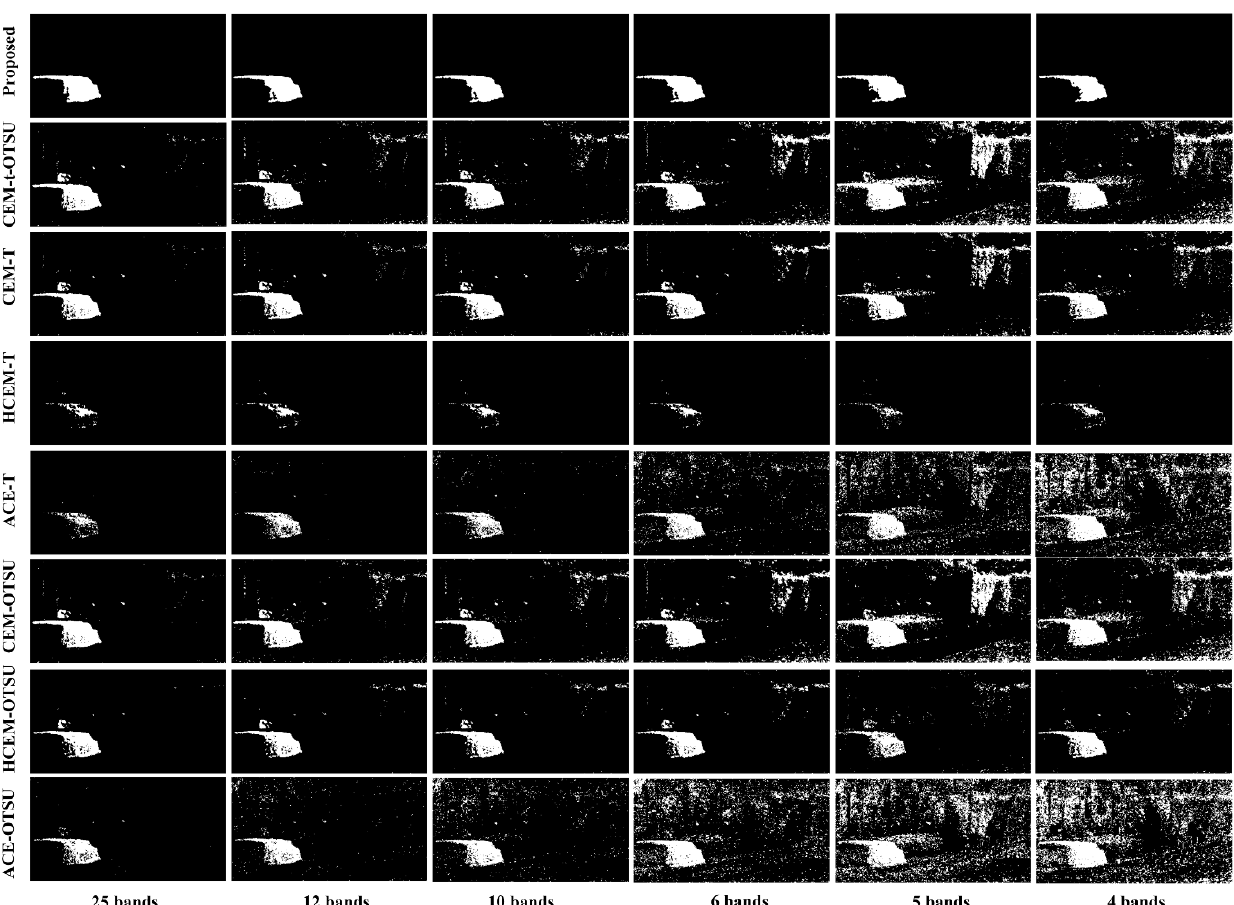
Figure 11. The detection results of different methods for the ASRC-net in the BT scene with bands ranging from 4 to 25. All the results are normalized to [0,1] for a fair comparison.